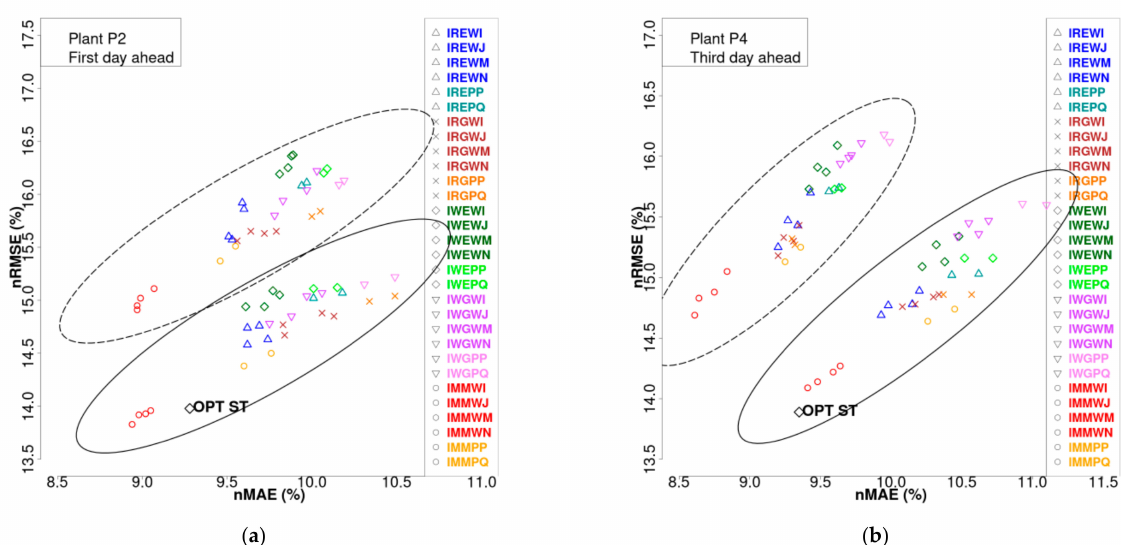
Figure 7. Normalised root mean square error (nRMSE) vs. relative Mean Absolute Error (nMAE) of the M members of the ensemble for plant P2 (forecasts for the first day ahead) ( a ) and plant P4 ( b ) (forecasts for the third day ahead). Inside the dashed ellipses there are drawn members obtained using median of AnEn pdf, inside the continuous ellipses those obtained using the mean of pdf. The blue rhombuses indicate the errors of the optimized power